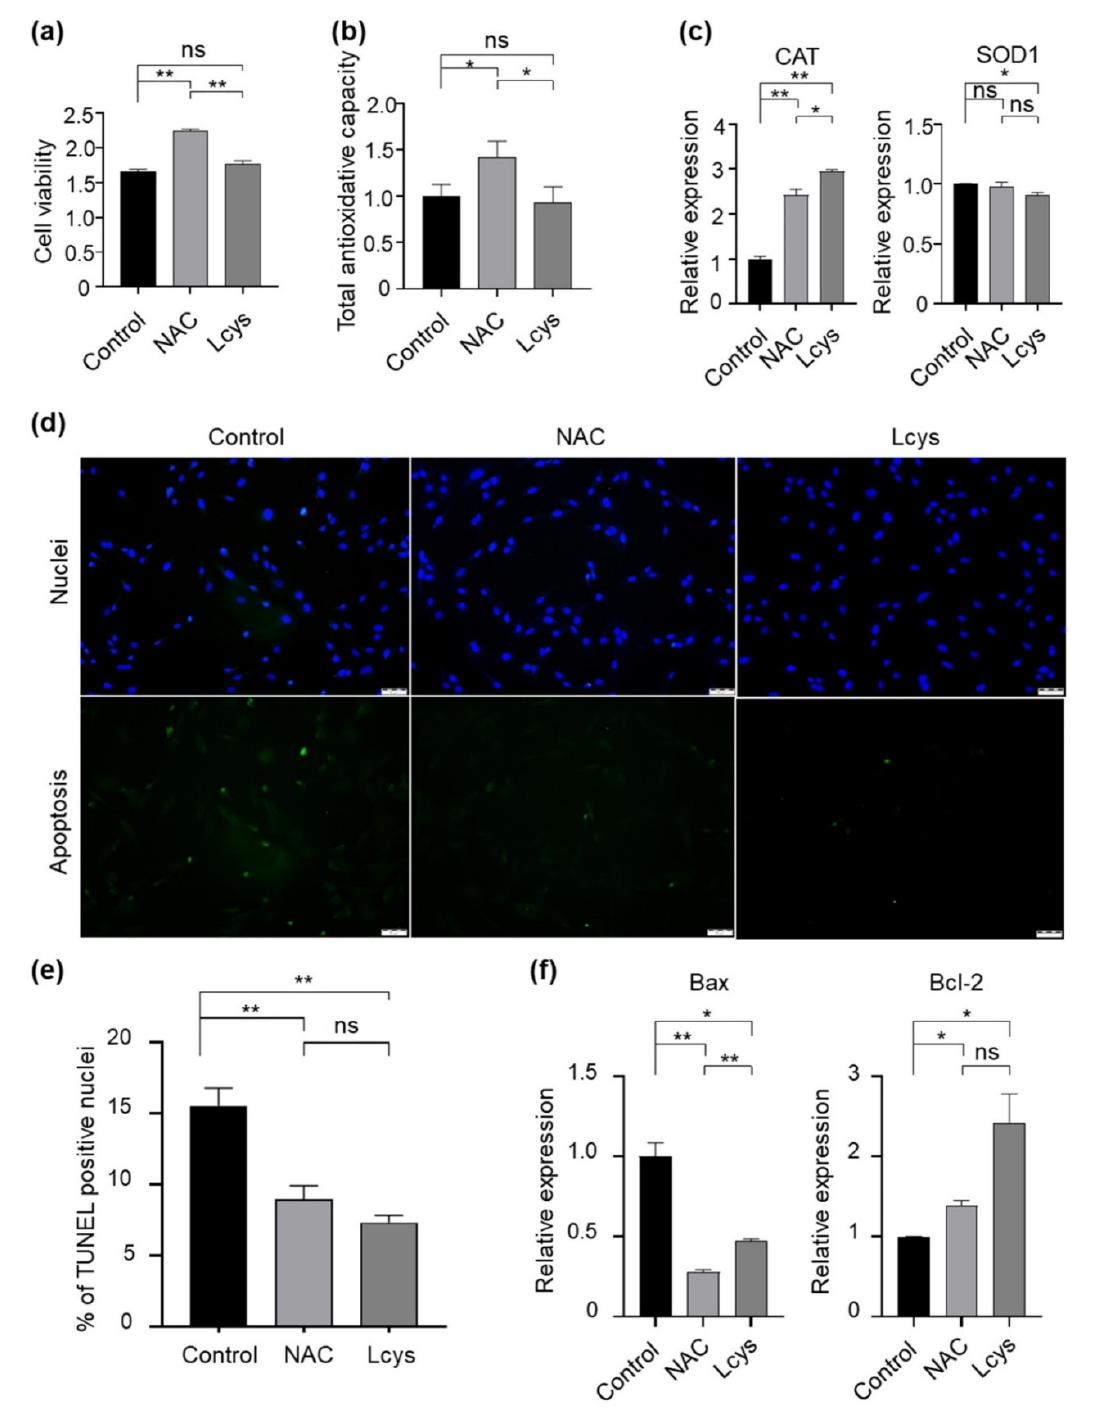
Figure 3. Supplementation of NAC and L-cysteine improves the quality of cumulus cells peeled from oocytes matured in vitro. ( a ) Cell viability was determined with an MTT assay. ( b ) Total antioxidant capacity of cellular content (TAC) was analyzed by an ELISA kit following the manufacturer’s instructions. ( c ) The expression levels of antioxidase genes ( CAT and SOD1 ) were detected by real-time qPCR and normalized with GAPDH . ( d , e ) Apoptotic cells were detected by the TUNEL assay. ( f ) The expression levels of apoptosis-related genes ( Bax / Bcl-2 ) were detected by real-time qPCR and normalized with GAPDH . Scale bars = 100 μ m. NAC, N-acetyl-L-cysteine; Lcys, L-cysteine. Values are means ± SEM calculated from three replicates; ns, no significant difference; *, p < 0.05; **, p < 0.01.